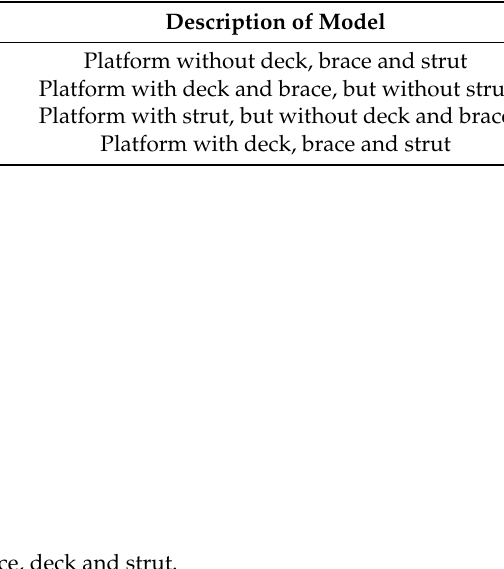
Table 5. Description of four models used for the structural optimization of the platform.